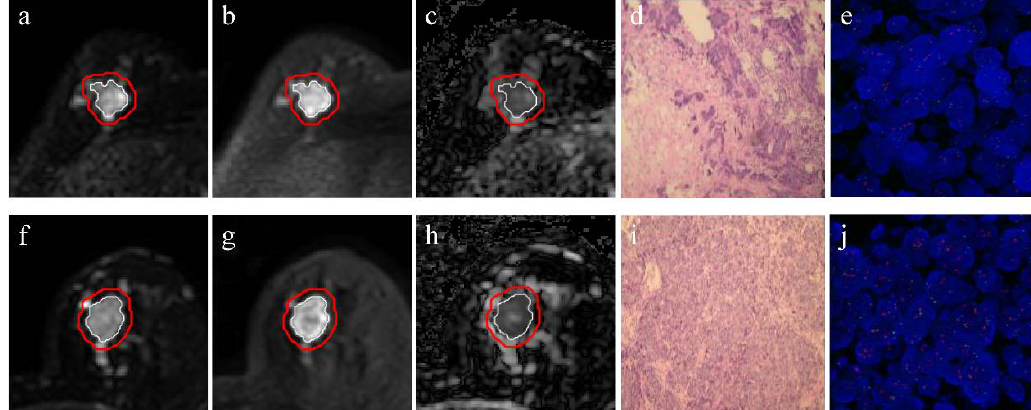
Figure 2. Intratumoral segmentation, peritumoral segmentation, pathology, and FISH results of randomly selected cases with negative and positive HER-2 2+. Case with negative HER-2 2+: ( a ) DWI b=0 , ( b ) DWI b=800 , ( c ) ADC map, ( d ) pathology findings, and ( e ) FISH results. Case with positive HER-2 2+: ( f ) DWI b=0 , ( g ) DWI b=800 , ( h ) ADC map, ( i ) pathology findings, and ( j ) FISH results. The white and red lines indicate the intratumoral and peritumoral margins on DWI b=0 , DWI b=800 , and ADC images,